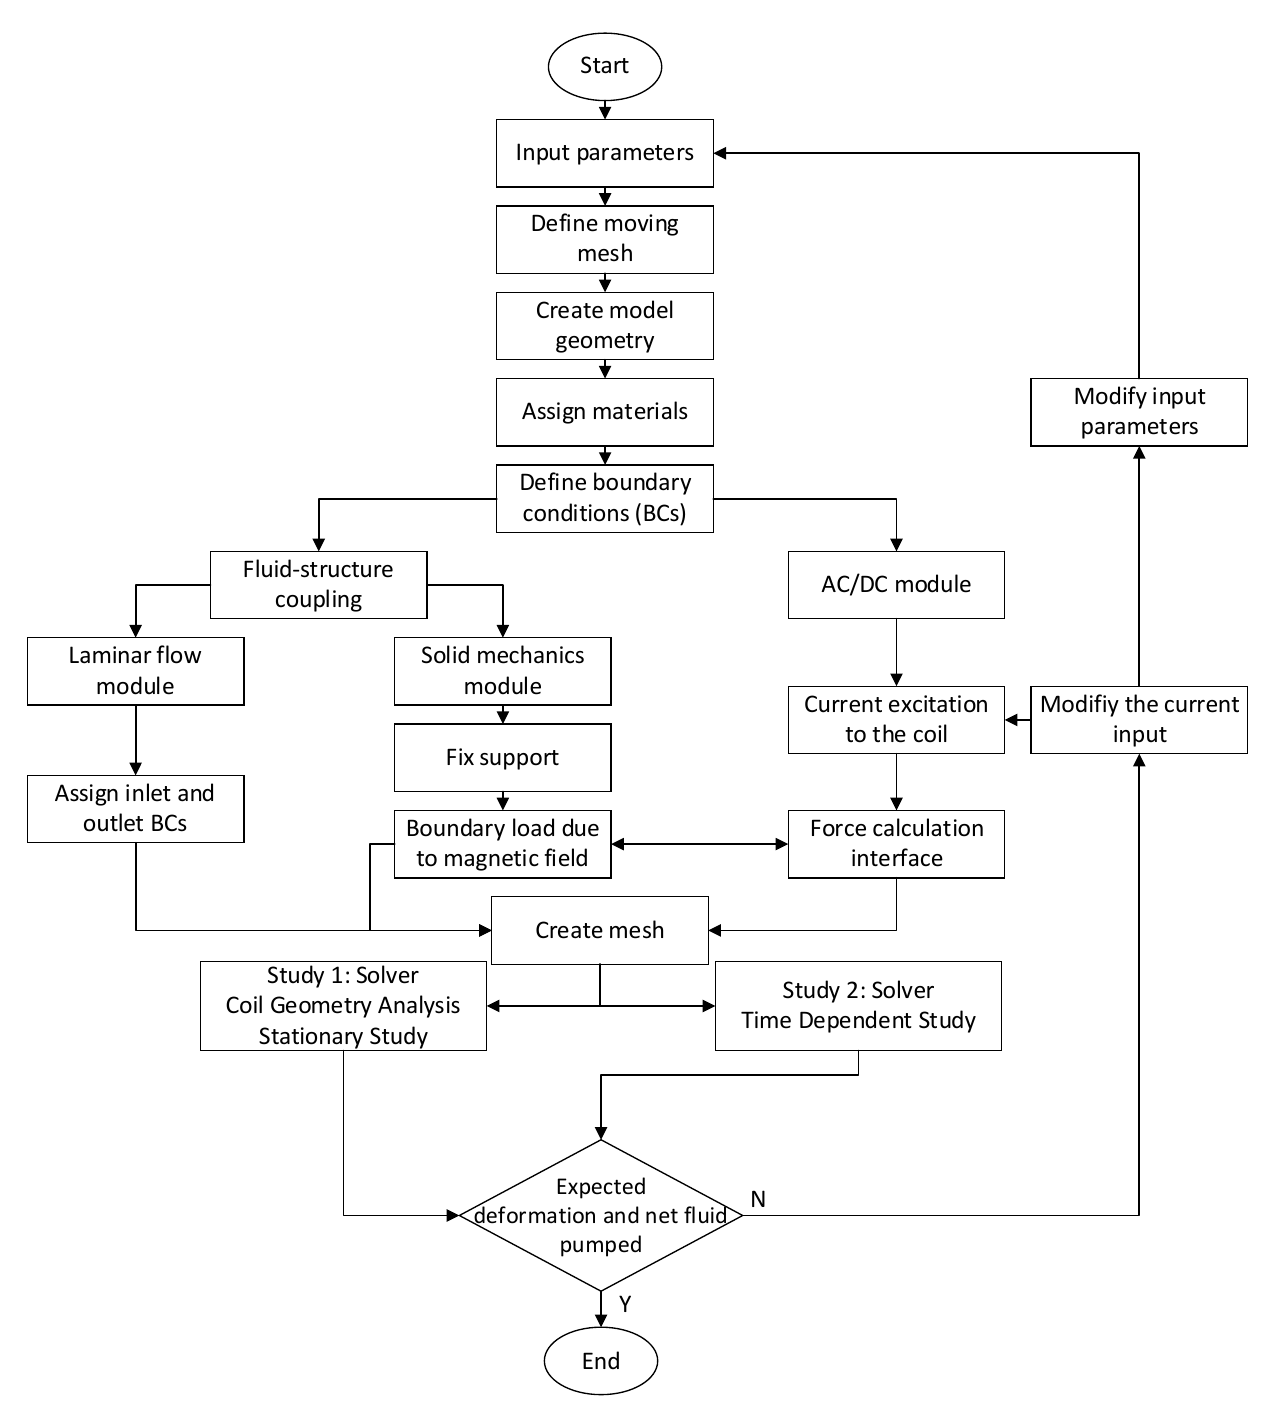
Figure 5. Flowchart of the simulation process in COMSOL.